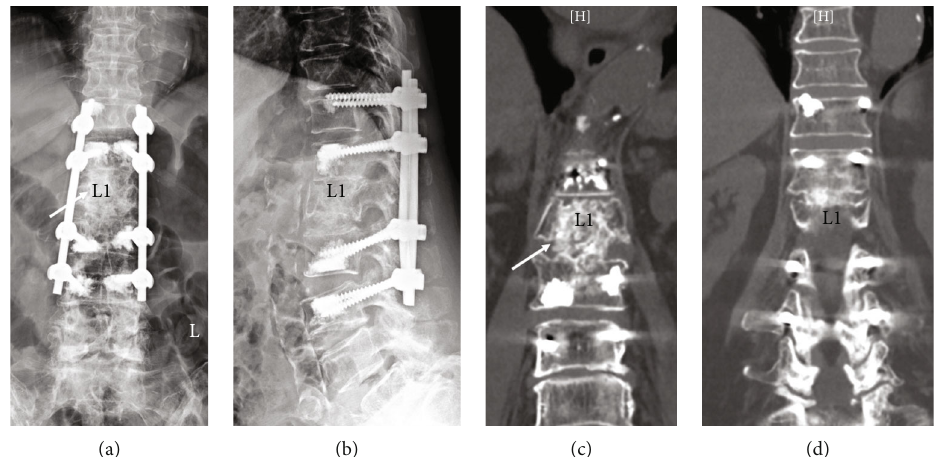
Figure 2: (a, b) After transforaminal debridement and impaction of bone graft, posterior pedicle instrumentation using cement-augmented pedicle screws was placed from T11-L3. At three years follow-up, the fusion mass between L1/L2 (c) and T12/L1 (d) was